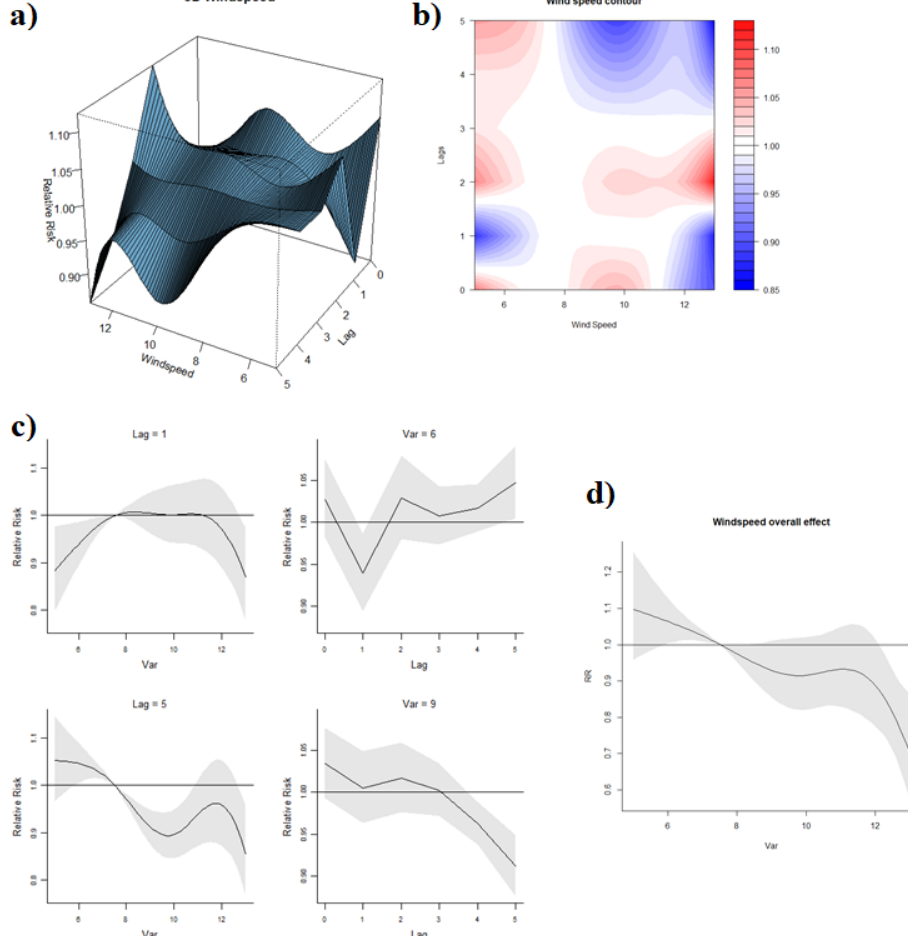
Figure 6. ( a ) 3D graph of wind speed-lag-dengue association; ( b ) contour graph of wind speed-lag- dengue association; ( c ) sliced graph of wind speed/lag-dengue association (Notes: left top panel shows wind speed-dengue association at lag 2 while the left bottom one at lag 5; right top panel shows a lag-dengue association at wind speed 6 km/h while the right bottom one at wind speed 10 km/h); ( d ) overall effect graph of wind speed-dengue association.